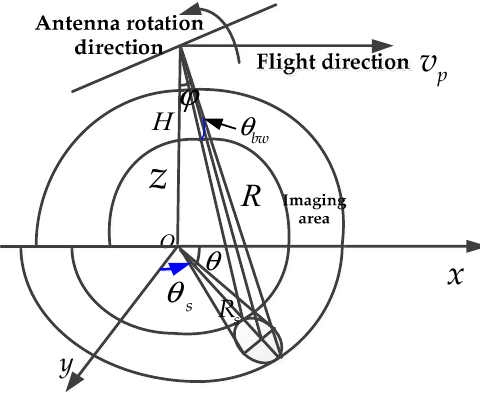
Figure 1. Schematic geometry of the airborne circular scanning SAR.